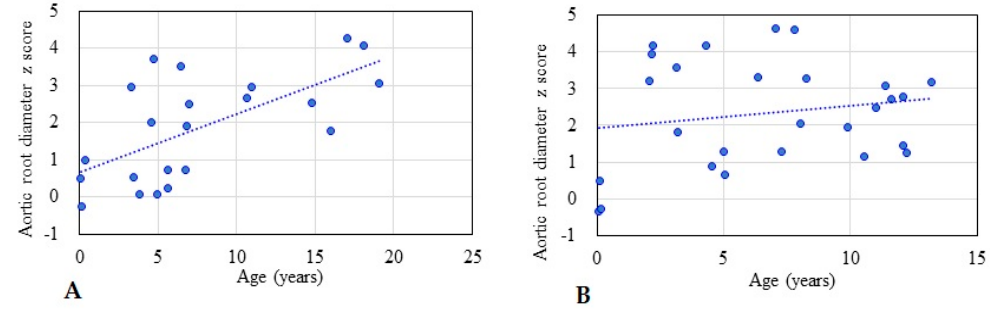
Figure 5. The relationships between aortic root diameter z score and age in the patients with the mild and severe forms of MPS II: ( A ) mild form ( n = 22, r = 0.642, p < 0.01); ( B ) severe form ( n = 27, r = 0.180, p > 0.05). The dotted line represents the